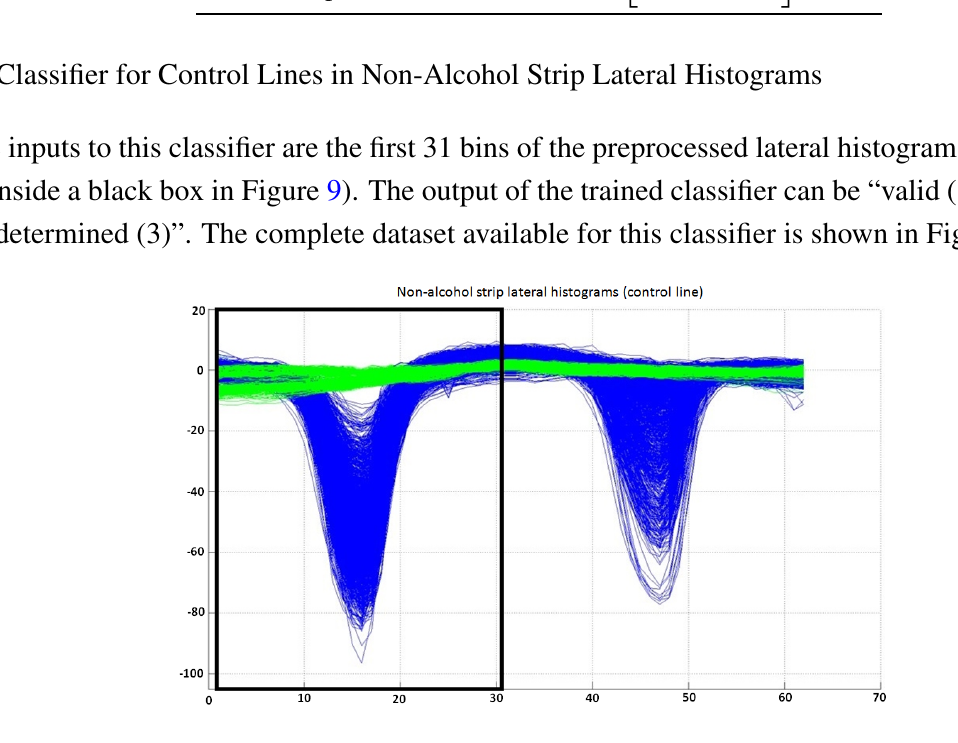
Figure 9. Lateral histograms used as the dataset for the classifier for control lines for non-alcohol strip lateral histograms. Samples labeled as “invalid” are represented in green, while “valid” samples are represented in blue. Note that only the first 31 bins of each lateral histogram are used by this classifier. It can also be observed that the separability between classes is very good, allowing the use of only three classes in this classifier (“valid”, “invalid” or